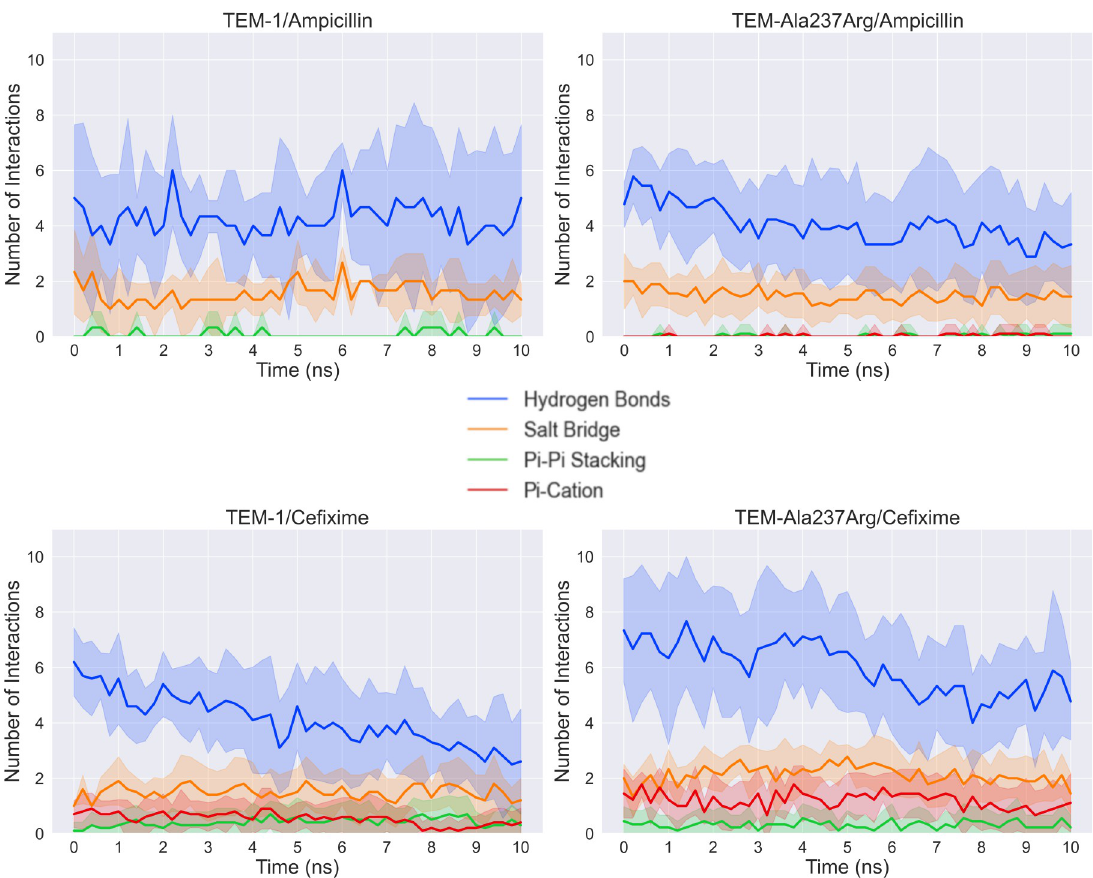
Fig 7. Interaction analysis between the ligand and the active site residues of complexes with TEM-1 (left) and TEM-Ala237Arg (right). Data are averaged from ten replicates of MD simulations. Ampicillin possesses a smaller number of pi interactions than cefixime because cefixime is more aromatic. In addition, pi interactions must fall into a very small range of angles to be considered present, and thus are more likely to be absent when the ligand binding mode is unstable. The shading denotes the standard deviation of the number of interactions for each system.